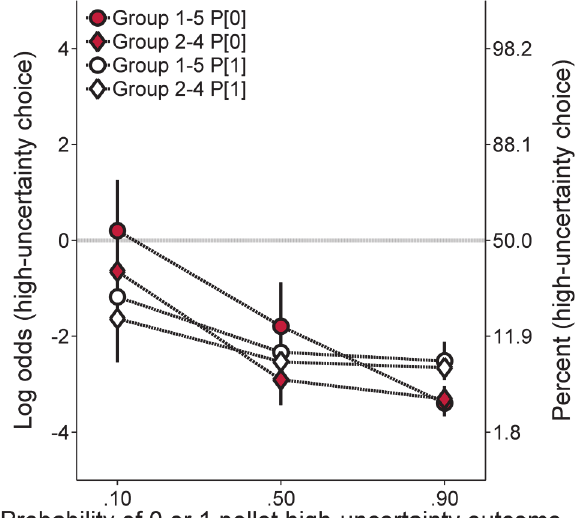
Fig 7. Mean ( ± SEM) log odds of high-uncertainty choices for each group in the high-uncertainty probability training procedure of Experiment 3A as a function of the probability of the 0-pellet outcome (P[0]) or the 1-pellet outcome (P[1]). Note that high-uncertainty choices are plotted against the probability of the manipulated outcome rather than as a function of overall probability of food, as was the case in previous figures. A second ordinate showing percentages corresponding to the log odds values was included to aid interpretation.